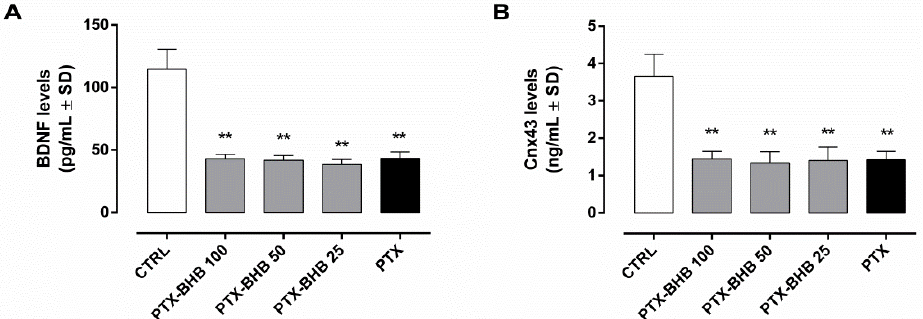
Figure 6. Retinal levels of BDNF ( A ) and Cnx43 ( B ) in non-diabetic mice (CTRL), diabetic mice treated with PTX (1 µg/100 µL) (PTX) and diabetic mice treated with both PTX and BHB 25 mg/kg (PTX-BHB 25), 50 mg/kg (PTX-BHB 50), and 100 mg/kg (PTX-BHB 100). BDNF (pg/mL) and Cnx43 (ng/mL) levels are expressed as mean ± SD of N = 8 retinas per group. ** p < 0.01 vs. CTRL. Similarly, retinal Cnx43 levels were decreased by PTX in diabetic animals (1.4 ± 0.2 ng/mL, p < 0.01 vs. CTRL) and were not modified in BHB diabetic animals receiving PTX (BHB 25: 1.4 ± 0.4 ng/mL; BHB 50: 1.3 ± 0.3 ng/mL; BHB 100: 1.4 ± 0.2 ng/mL) (Figure 6B).